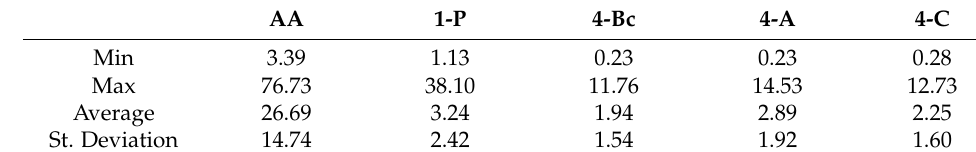
Table 1. Grain size data of the AA and ECAPed ZK30 billets. All units are in µ m.